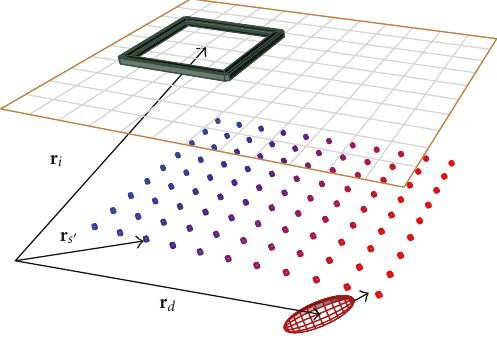
Figure 2: Determining the location and orientation of a buried target. The method assumes the object is a point dipole and exploits an analytic relation between the field measured at r i and the scalar potential at the same point to find the location r d . The potential is constructed using a layer of equivalent magnetic sources placed between the sensor and the object; r s (cid:2) is a typical location on the